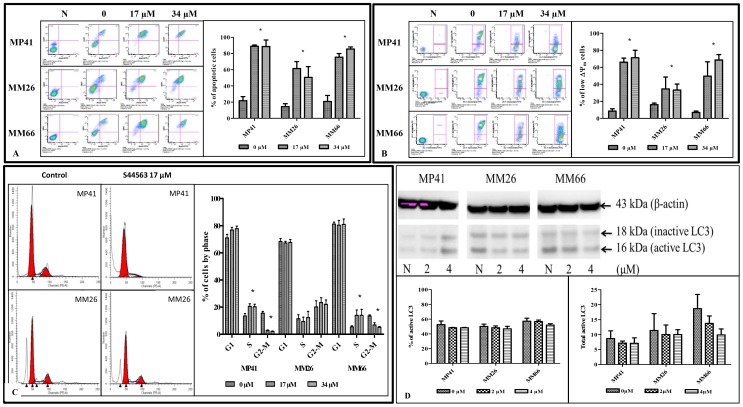

In vitro apoptosis induction by S44563.A and B. Apoptosis induction by S44563. The MP41, MM26, and MM66 cell lines were incubated with 17 µM and 34 µM S44563 for 24 hours, after which the samples were labeled with DAPI/annexin V-FITC (A) or JC1 (B). The proportion of annexin V-positive cells and low Δψm cells was indicated in C and E, respectively. A two-way ANOVA with Bonferroni post-test was then performed (* p<0.05). C. Cell cycle analyses after S44563 exposure (17 or 34 µM for 24 h) in the 3 UM cell lines. Cell cycle analysis was determined by labeling the DNA with propidium iodide. Each of the three lines was treated by 17 µM or 34 µM of S44563. The proportion of cells (%) in different cell cycle phases was compared with the control (untreated). Two-way ANOVA with Bonferroni post-test was then performed (* means a p<0.05). D. Cell cycle analyses of the xMP41 UM cell line. I and J. Measurement of autophagy on the 3 UM cell lines after S44563 exposure (2 or 4 µM for 24 h). After S44563 treatment, the amount of active and inactive protein LC3 was determined and reported to ß-actine. The quantity of total LC3 protein was calculated to study the activation of LC3. Results were presented as percentage and total amount of active cleaved LC3, relative to β-actin. A two-way ANOVA with Bonferroni post-test was then performed (* means a p<0.05).